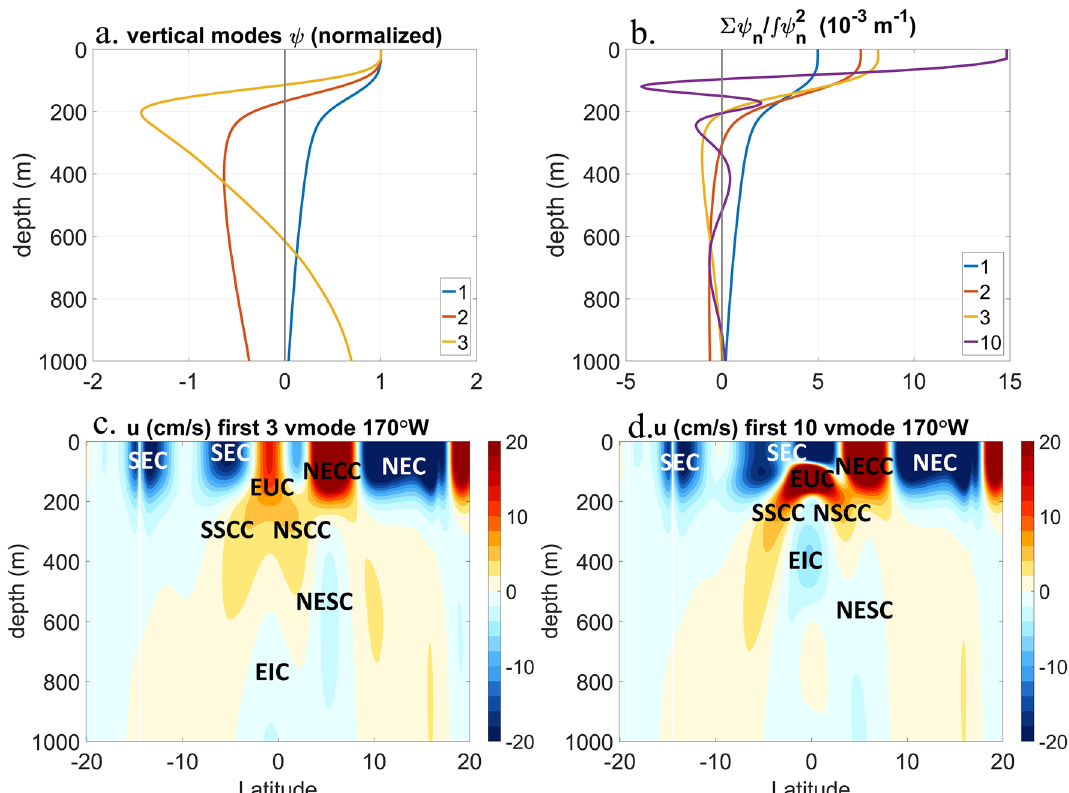
Figure 5. ( a ) Baroclinic modes functions (first three), and ( b ) progressive superpositions of the first 3 baroclinic modes functions scaled by equivalent depths compared with the superposition of the first 10 scaled baroclinic mode functions. The steady-state solution of the linear continuously stratified model (LCSM) in the meridional section of 170° W with first 3 ( c ) or 10 ( d ) baroclinic modes. The main zonal currents are marked in ( c ) and ( d ), including the North and South Equatorial Currents (NEC, SEC), the North Equatorial Countercurrent (NECC), the Equatorial Undercurrent (EUC), the Equatorial Intermediate Current (EIC), the Northern and Southern Subsurface Countercurrents (NSCC, SSCC), and the NESC. Colors stand for the magnitude of the zonal velocity, blue for the westward currents and red for the eastward currents, respectively. The baroclinic modes functions are normalized by values at the surface. Unit of the zonal velocity is cm s −1 . The figure is generented by MATLAB software version R2019b (https ://www.mathw